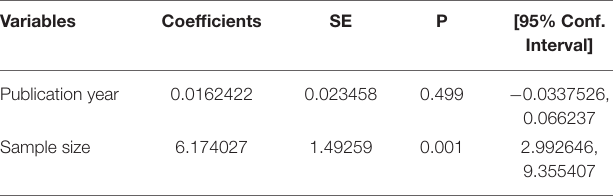
TABLE 2 | Results of meta-regression analysis to check heterogeneity on rectovaginal colonization of GBS among pregnant women in Ethiopia, 2021.